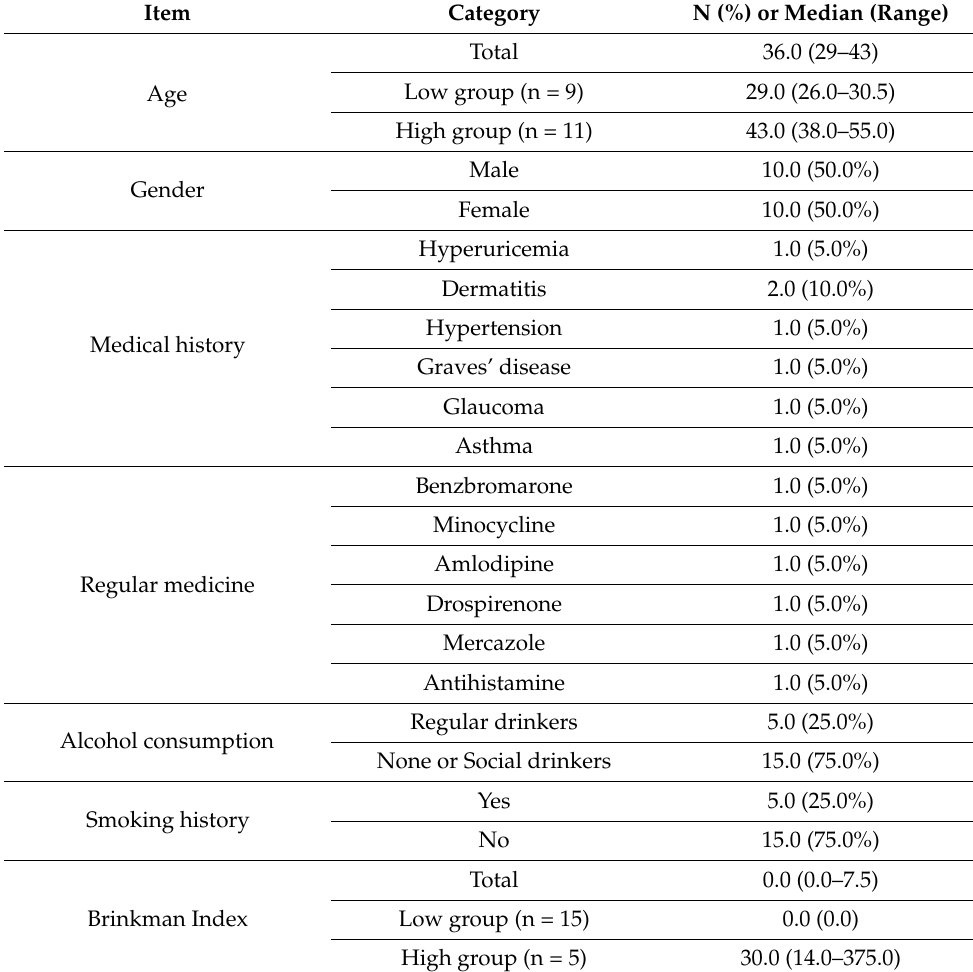
Table 1. Demographic data (n =